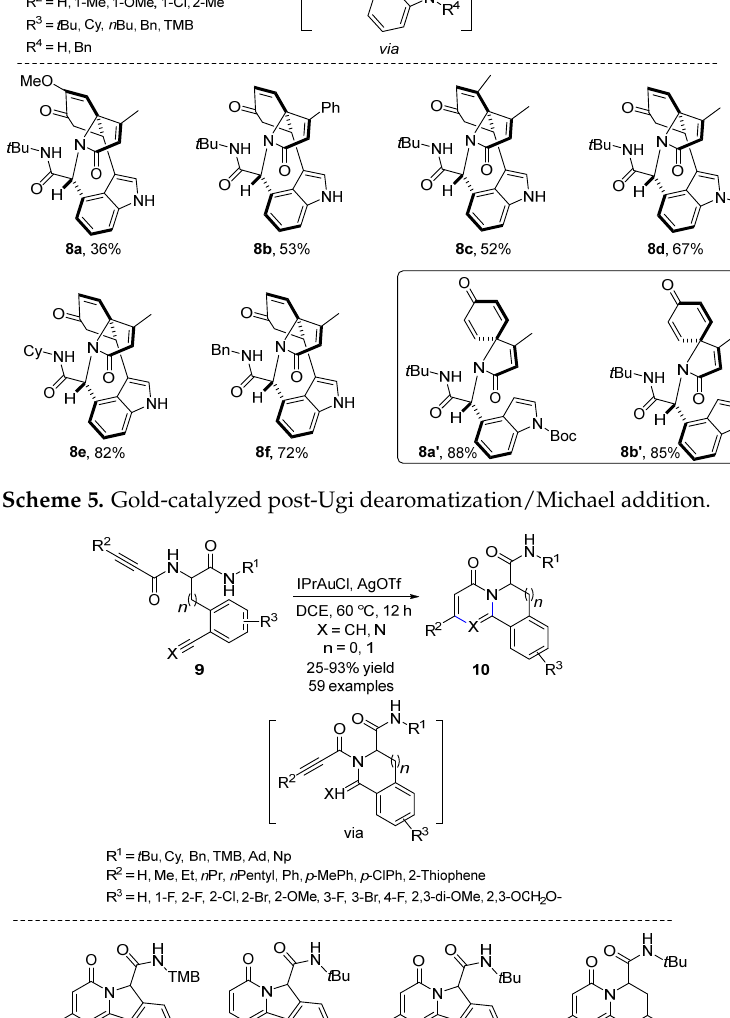
Scheme 7. Gold ‐ catalyzed 6 ‐ endo ‐ dig cyclization/enyne cycloisomerization/1,2 ‐ migration process. Afterwards, the same group integrated gold ‐ catalyzed hydroarylation with Michael addition for the production of diverse benzazepinoindole polycyclic scaffolds in a highly efficient manner [24]. This method showed a broad substrate scope, excellent functional group tolerance, and high yield (Scheme 8). Hydrogen and alkyl groups such as methyl,